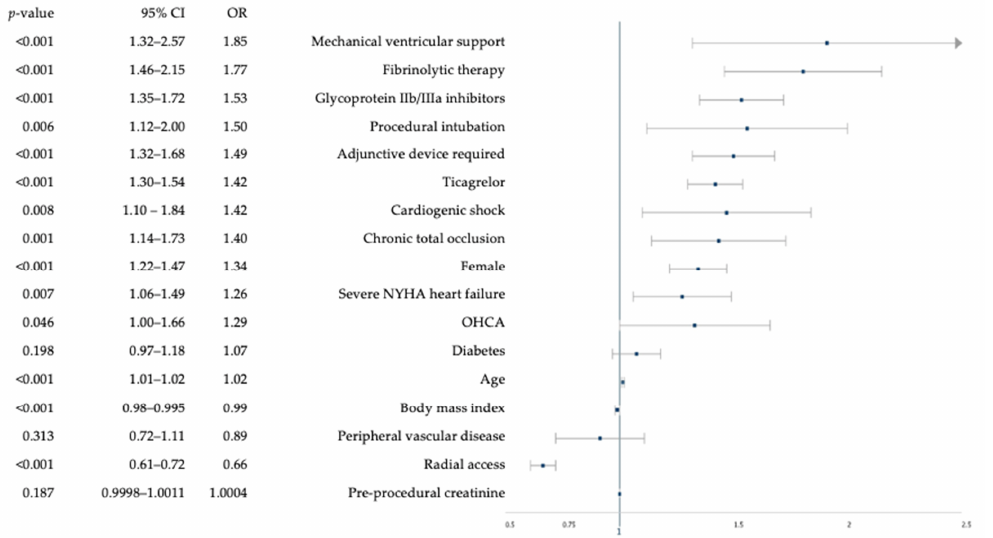
Baseline characteristics that independently predicted BARC-defined bleeding were older age (OR 1.02, 95% CI: 1.01–1.02), female sex (OR 1.34, 95% CI: 1.22–1.47), fibrinolytic therapy (OR 1.77, 95%